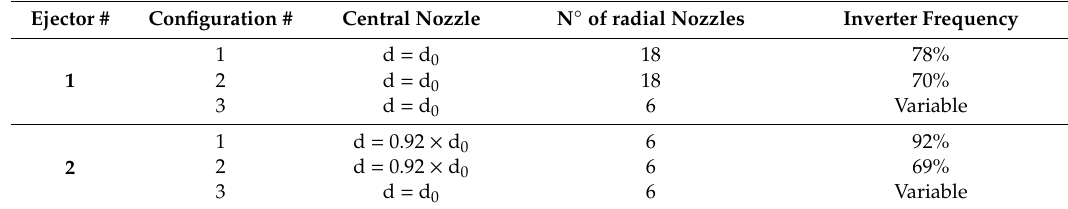
Table 3. Characteristics of pilot plant configurations tested in Cattolica. The frequency of each inverter is expressed as a percentage in the range 12.5–50 Hz, being 0% corresponding to 12.5